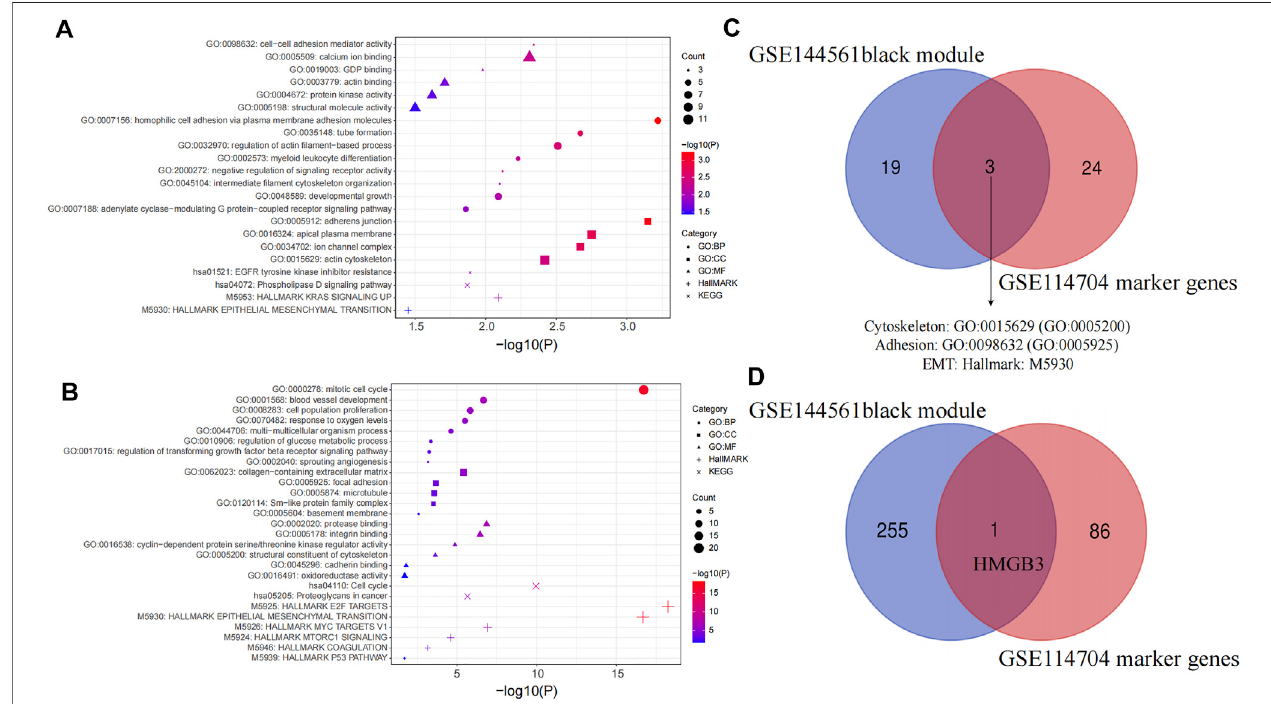
FIGURE7| Functionalenrichmentanalysis. (A) FunctionalenrichmentanalysisoftheblackmoduleinWGCNA,and (B) markergenebetweencluster0andcluster 1. GO, Gene Ontology; BP, biological processes; CC, cell components; MF, molecular functions; KEGG, Kyoto Encyclopedia of Genes and Genomes. (C) Venn plot of enriched pathways in GSE144561 black module and GSE114704 marker genes. (D) Venn plot of GSE144561 black module genes and GSE114704 marker